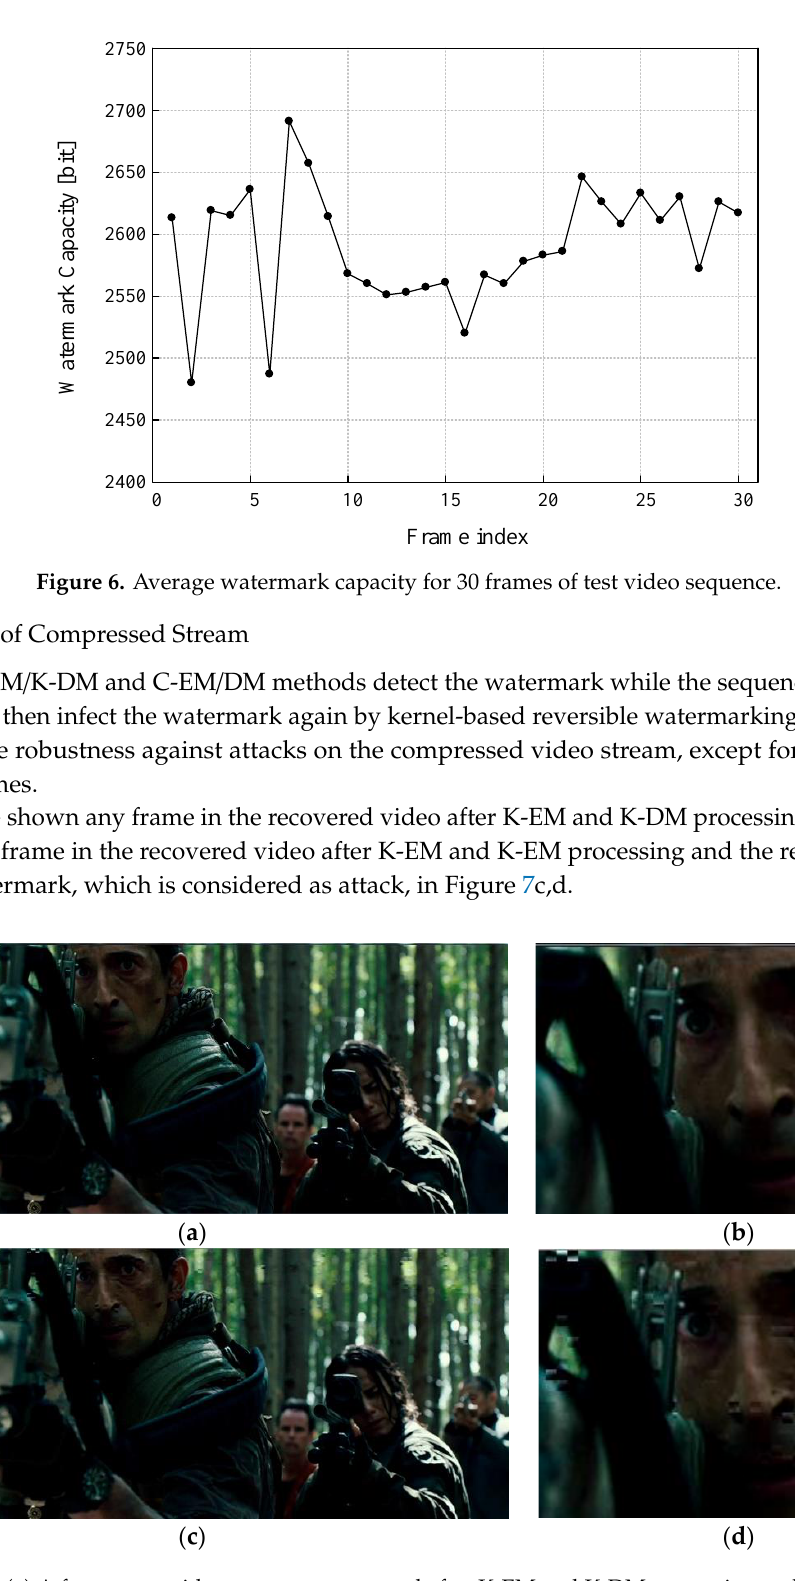
Figure 7. ( a ) A frame on a video sequence recovered after K-EM and K-DM processing and ( c ) a frame on a video sequence with blocking artifacts due to the recovery error by re-embedding the random watermarks. ( b ) and ( d ) are 30% enlarged versions of ( a ) and ( c ) respectively.